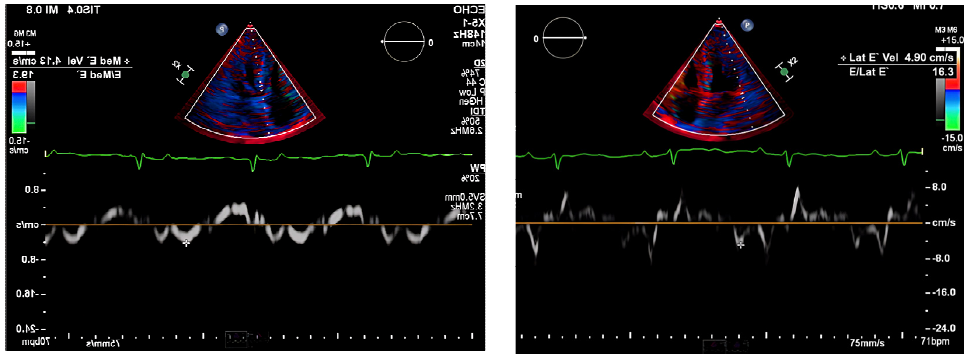
(cid:48) ratio and low mitral annulus